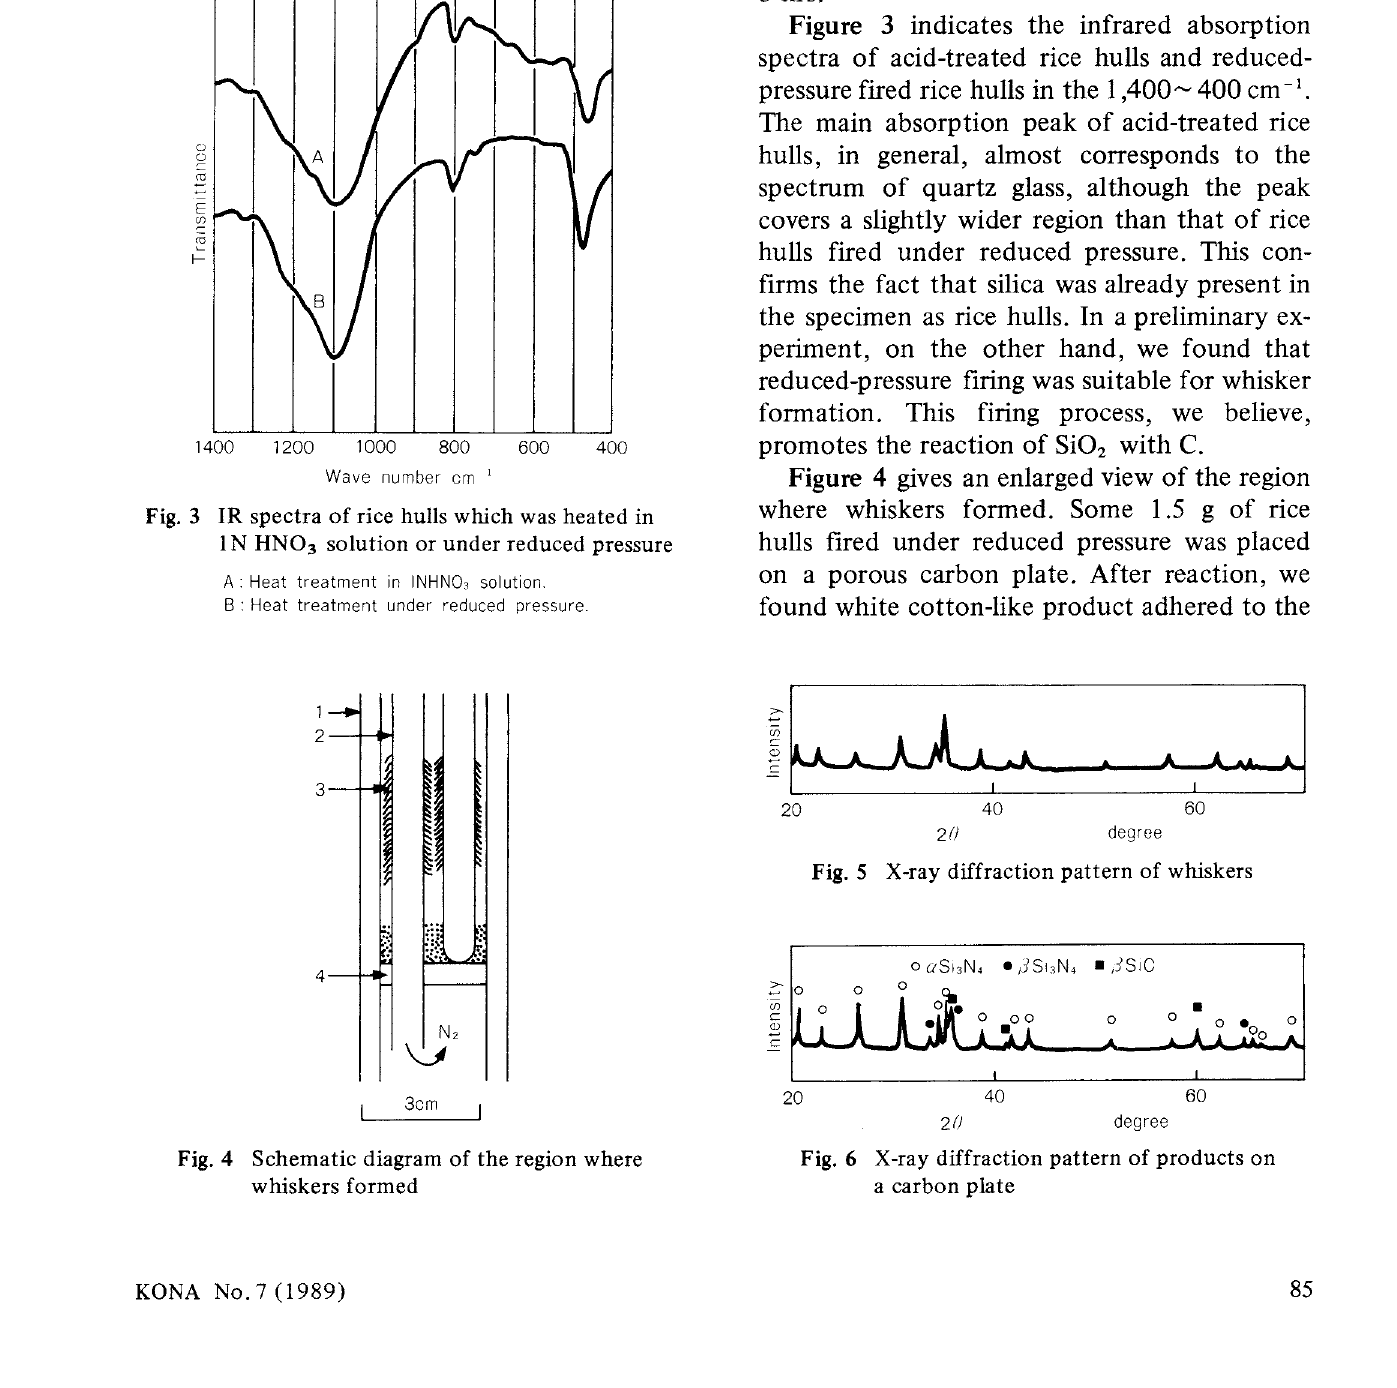
Fig. 4 Schematic diagram of the region where whiskers formed